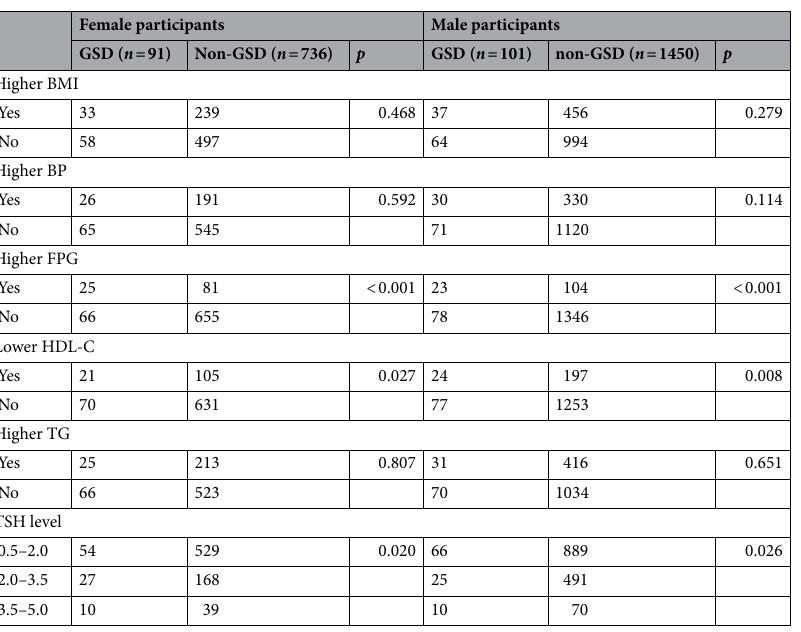
Table 2. Comparison of metabolic risk factors and TSH between GSD and non-GSD group in female and male participants. Data were presented as mean ± SD. Groups were compared using chi-square test. p < 0.05 was considered as statistically significance. *BMI: calculated as weight (in kilogram) divided by height (in meter). squared.